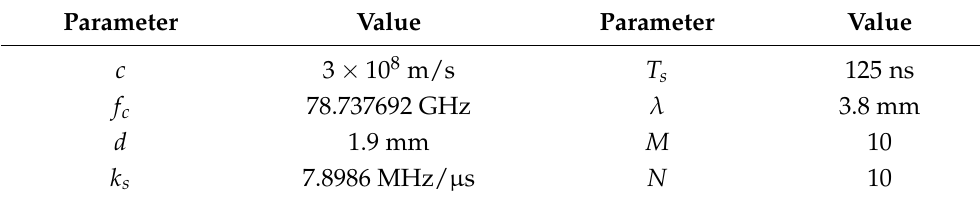
Table 4. Parameters of the FMCW